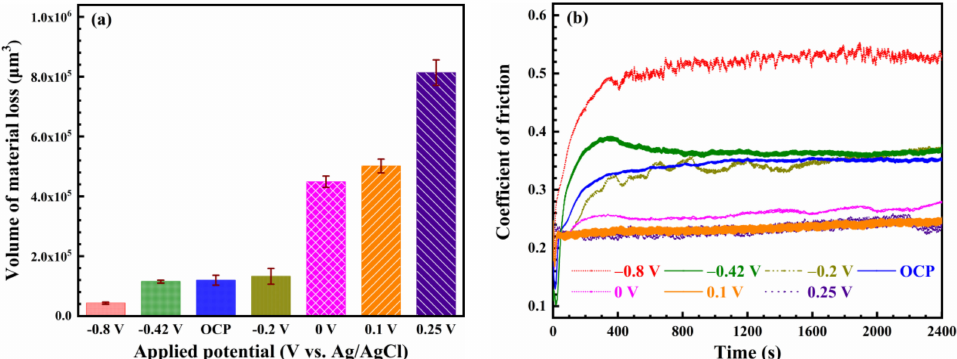
Figure 5. Wear volume ( a ) and friction Coefficient ( b ) of CoCrNi in 3.5 wt. % NaCl Solution under different applied